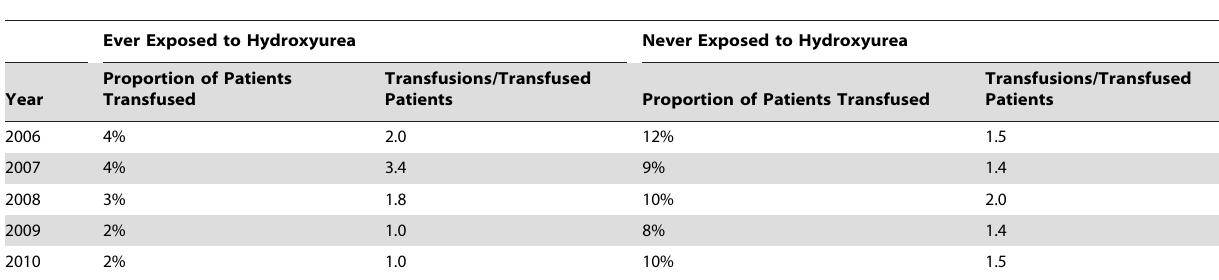
Table 3. PRBC* transfusions among those never exposed, and those exposed to hydroxyurea.